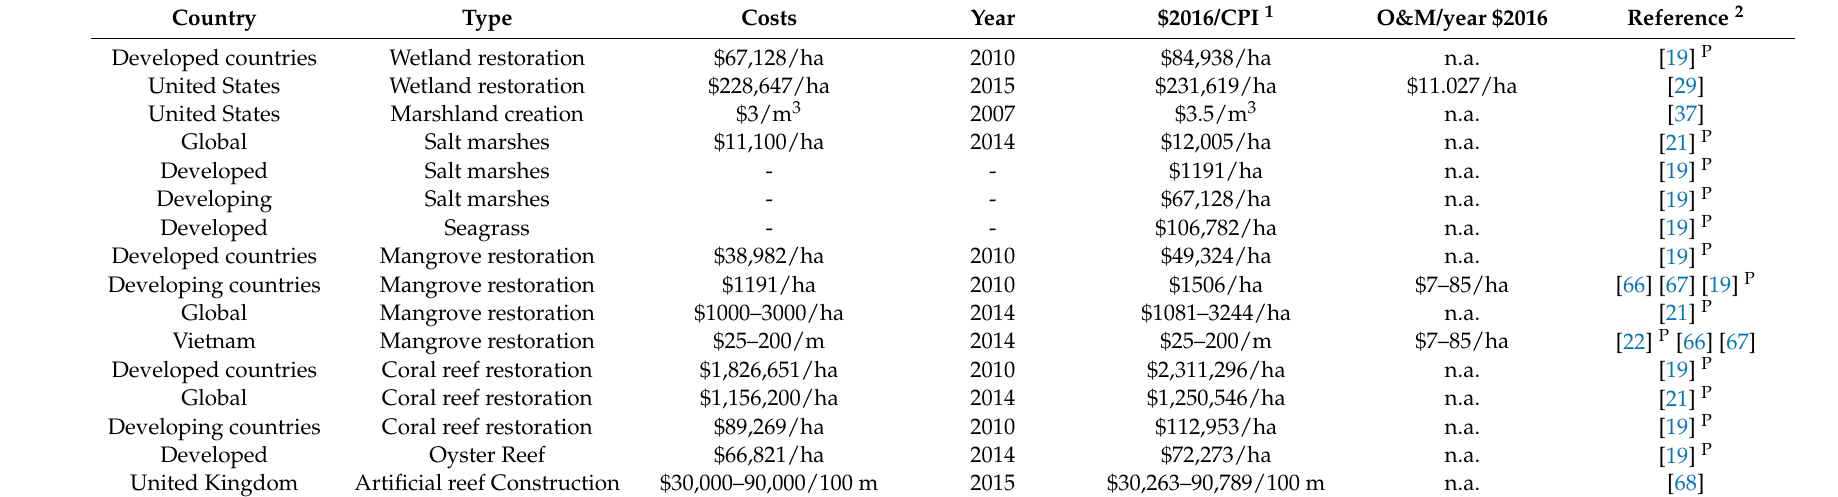
Table 6. Cost for nature-based solutions for coastal